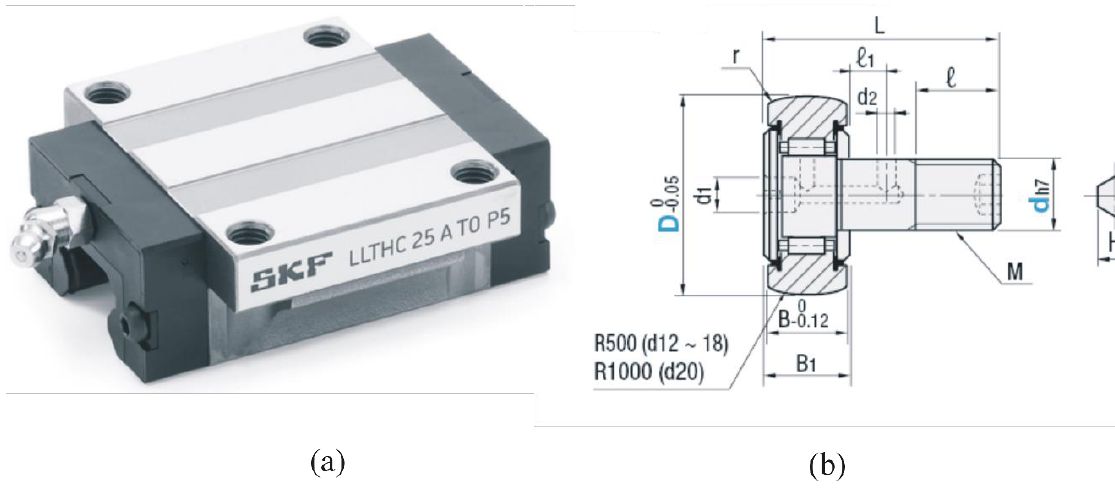
Figure 36: (a) Recirculating ball bearing and (b) cam follower bearing.